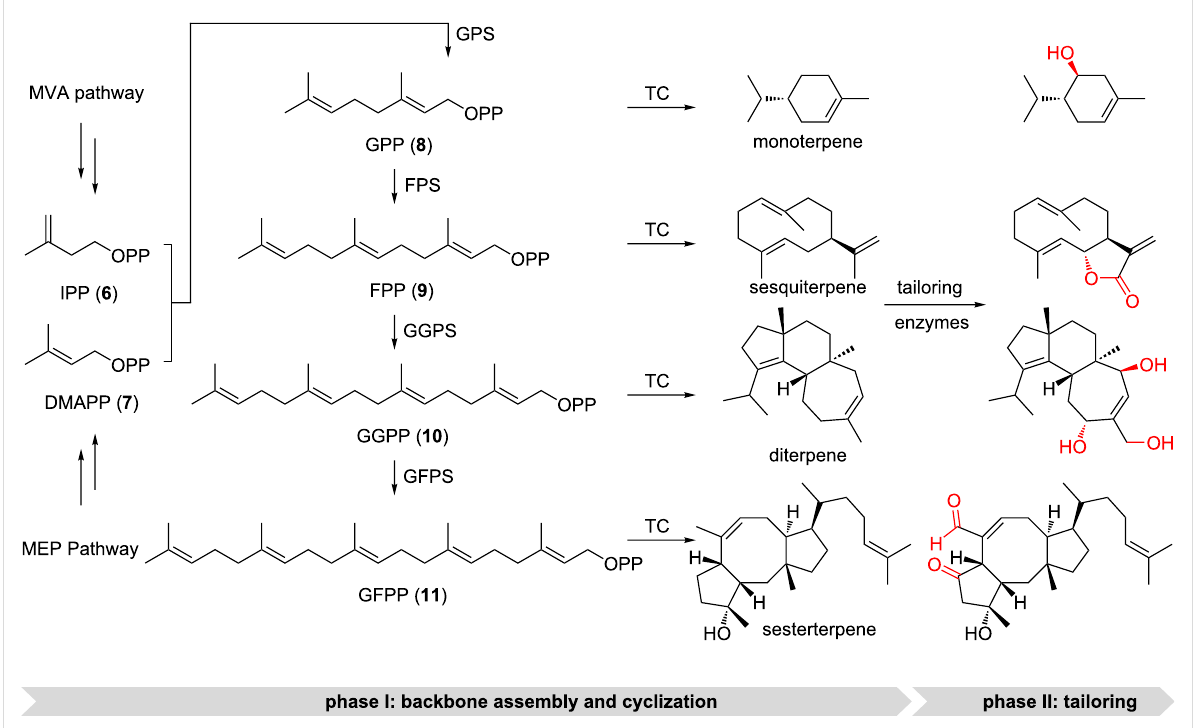
Figure 4: Terpenoid biosynthesis. Terpenoid biosynthesis is divided into two phases, 1) terpene scaffold generation and 2) terpene scaffold functio- nalization. Representative examples are shown with the modifications installed in the tailoring step highlighted in red. MEP: 2- C -methyl- ᴅ -erythritol 4-phosphate pathway, MVA: mevalonic acid pathway, IPP: isopentenyl pyrophosphate, DMAPP: dimethylallyl pyrophosphate, GPS: geranyl pyrophosphate synthase, GPP: geranyl pyrophosphate, FPS: farnesyl pyrophosphate synthase, FPP: farnesyl pyrophosphate, GGPS: geranylgeranyl pyrophosphate synthase, GGPP: geranylgeranyl pyrophosphate, GFPS: geranylfarnesyl pyrophosphate synthase, and GFPP geranylfarnesyl